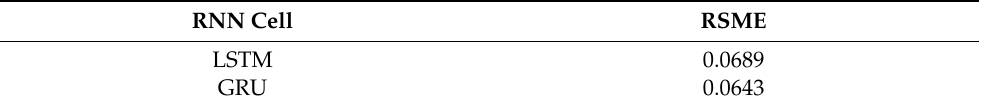
Table 16. Root mean squared error (RMSE) values of the Long Short-Term Memory (LSTM) and Gated Recurrent Unit (GRU) models.